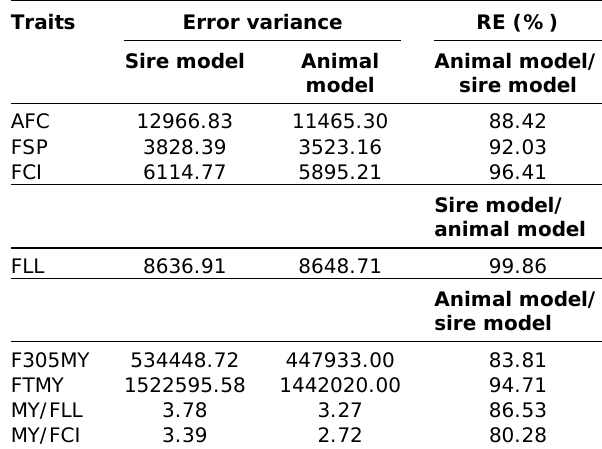
) estimates based on EBVs s